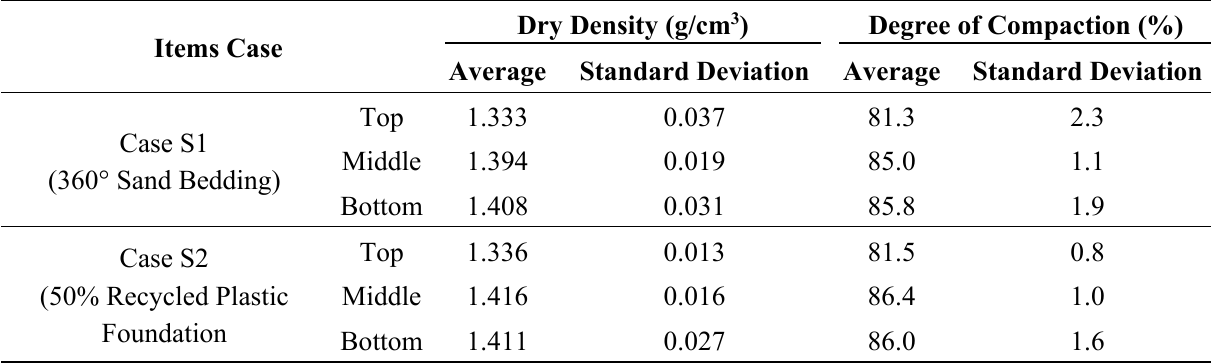
Table 2. Measured properties of sand backfill.